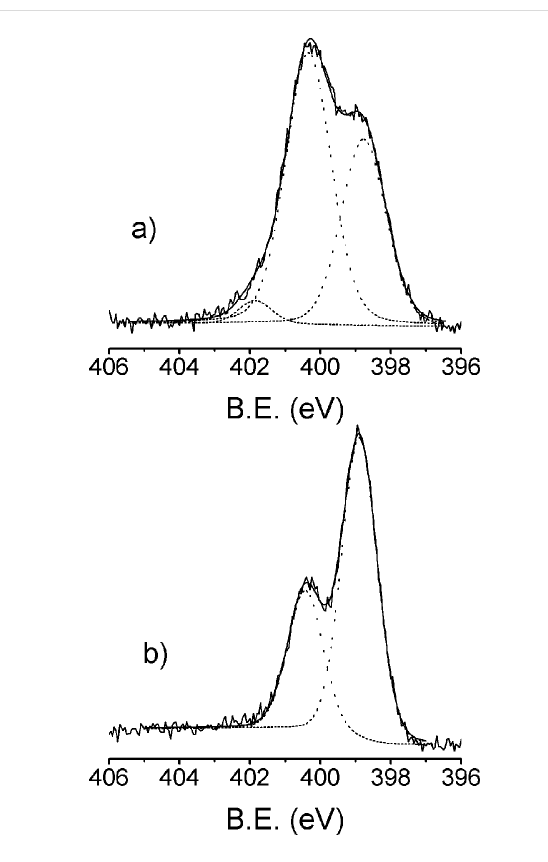
Figure 3: N 1s XPS spectral region of Si-1-Pc (a) and PSi-1-Pc (b).